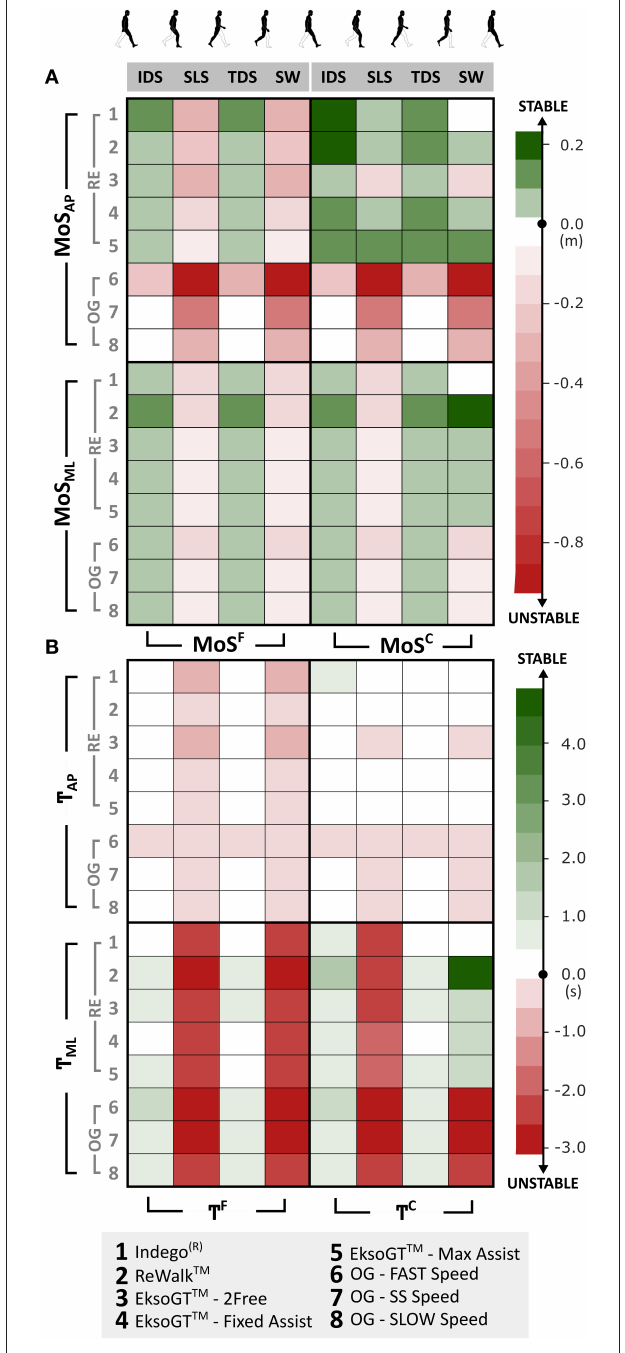
FIGURE 4 | (A) Stability matrix showing the lowest stability values (MoS min ) in both AP and ML directions during each phase of gait cycle [initial double support (IDS), single support (SS), terminal double support (TDS), and SWING] across RE and OG walking. (B) MoS normalized to CoM velocity (referred to as “temporal stability”—?) within each phase of the gait cycle.